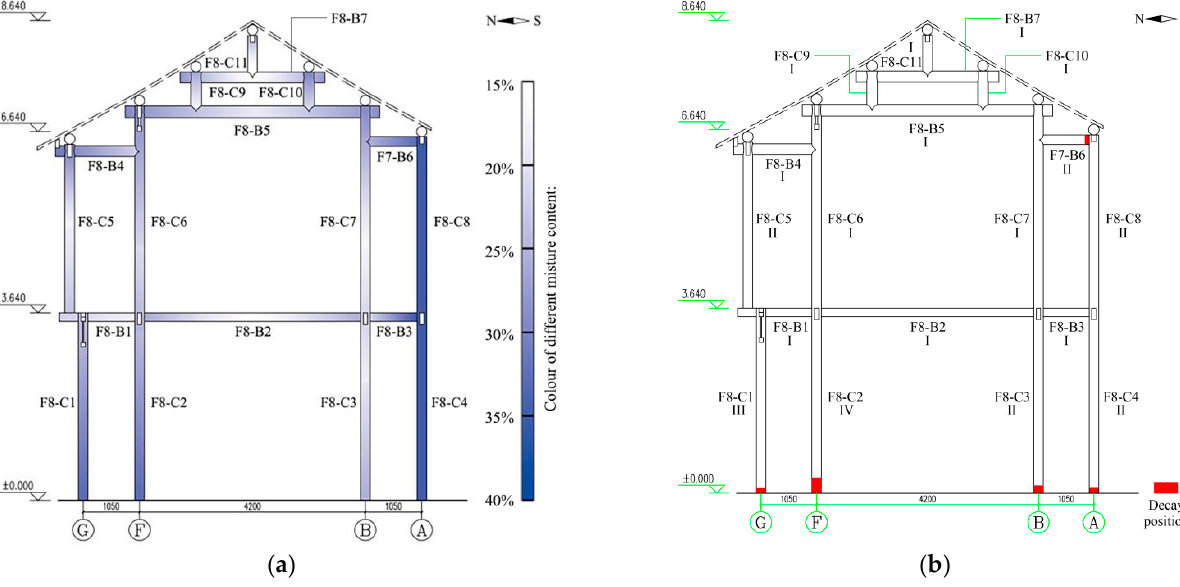
Figure 19. Moisture content and decay of F8 in Fujiu Zhou house; ( a ) schematic diagram of moisture content; ( b ) schematic diagram of decay position and decay grade.